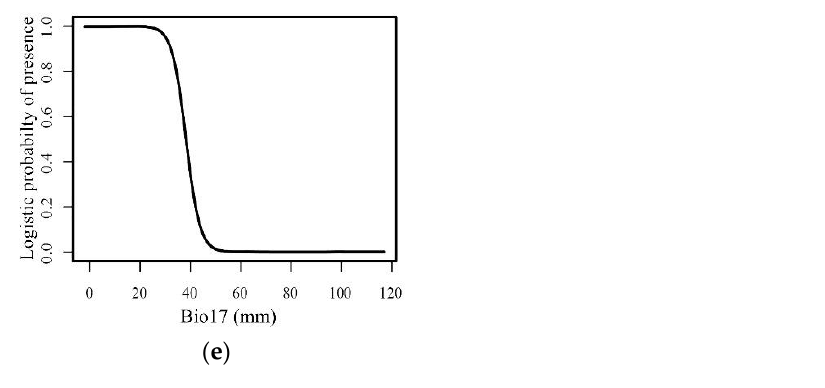
Figure 2. Quantitative relationship between environmental variables and habitat suitability to Dendroctonus armandi . ( a ) Bio1: Annual mean temperature (°C); ( b ) Bio6: Minimum temperature of coldest month (°C); ( c ) Bio9: Mean temperature of driest quarter (°C); ( d ) Bio15: Precipitation seasonality (Coefficient of variation) (%); ( e ) Bio17: Precipitation of driest quarter (mm).